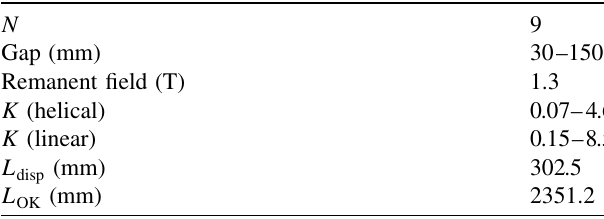
the total length. OK